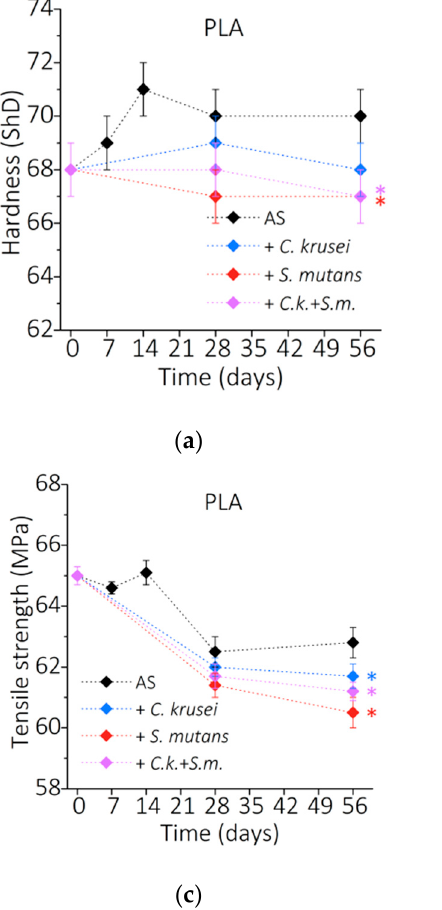
Figure 6. Mechanical properties of PLA and PCL during incubation in artificial saliva and microor- ganisms: ( a , b ) Shore hardness; ( c , d ) tensile strength. (*) p < 0.05.